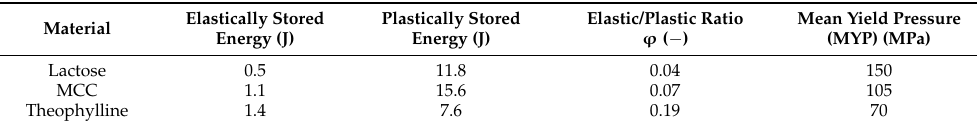
Table 4. Elastically and plastically stored energy during the compaction of 300 mg of materials ground without any additives at stresses of 400